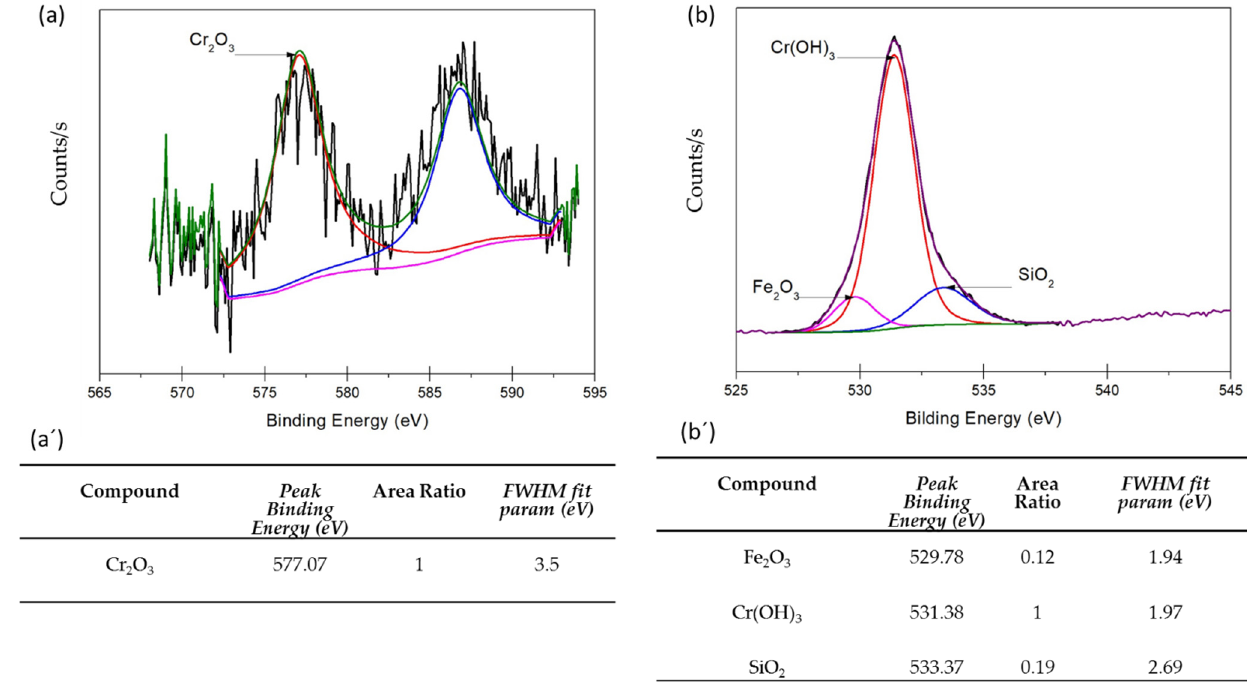
Figure 11. X-ray photoelectron spectra for CUSTOM450CA–75 min–49 °C: ( a ) Cr 2p, ( b ) O 1s. Parameters obtained: peak binding energy and FWHM fit param ( a’ ) Cr 2p, ( b’ ) O 1s.